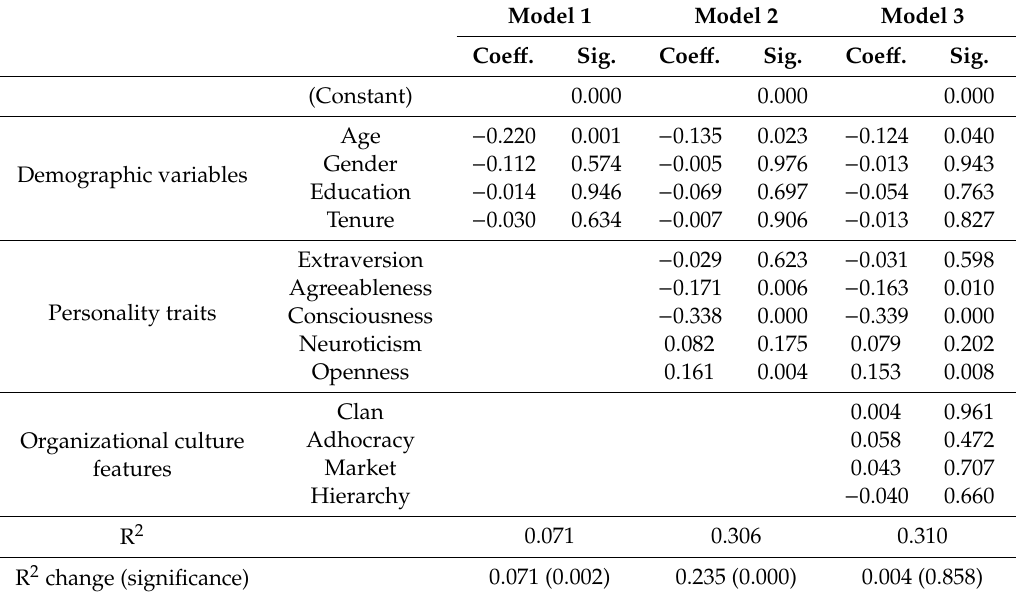
Table 2. Hierarchical linear regression results for organizational workplace deviant behavior and control variables, personality traits, and features of organizational